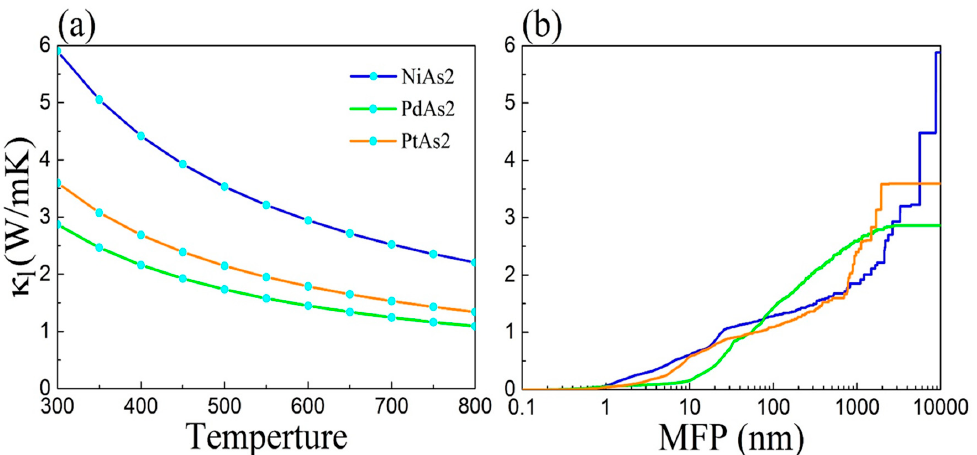
Figure 5. ( a ) Lattice thermal conductivities ( κ l ) of monolayer MAs 2 as a function of temperature, and ( b ) the phonon mean free path (MFP) as a function of accumulated κ l of monolater MAs 2 at 300 K. In order to analyze the influence of lattice thermal conductivity on TE performance in detail, we calculated the phonon group velocity ( v ), relaxation time ( τ ), Grüneisen parameters ( γ ) and the three- phonon scattering phase space (P 3 ) as presented in Figure 6.